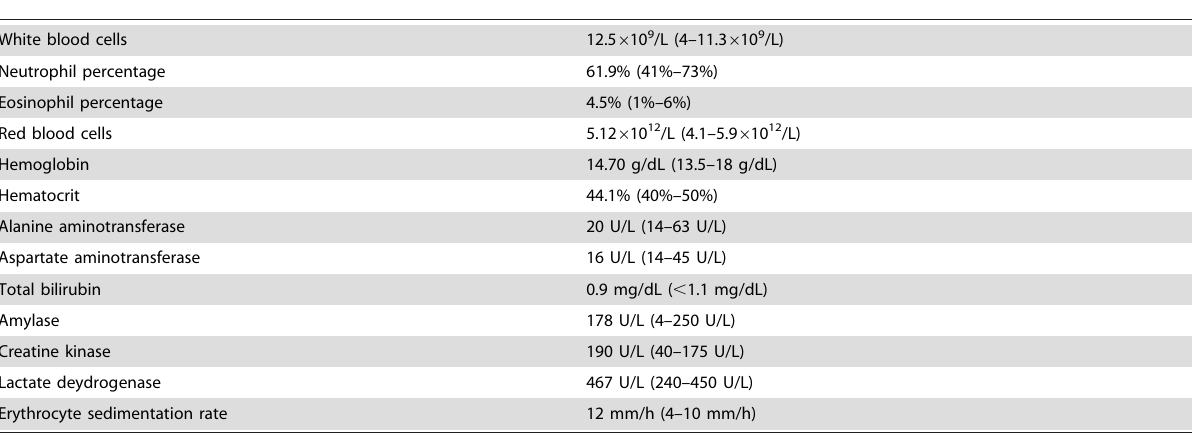
Table 1. Patient’s laboratory findings (normal values) at the admission.